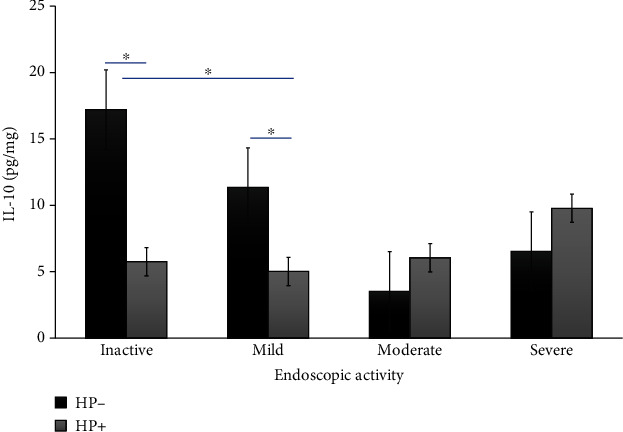
IL-10 levels in ulcerative colitis correlate with endoscopic activity. IL-10 levels in serum from UC patients according to Mayo subscore endoscopic activity; bars show means with standard error of the mean of IL-10, and differences among groups were assessed by the Mann–Whitney U test. ∗P value < 0.05.